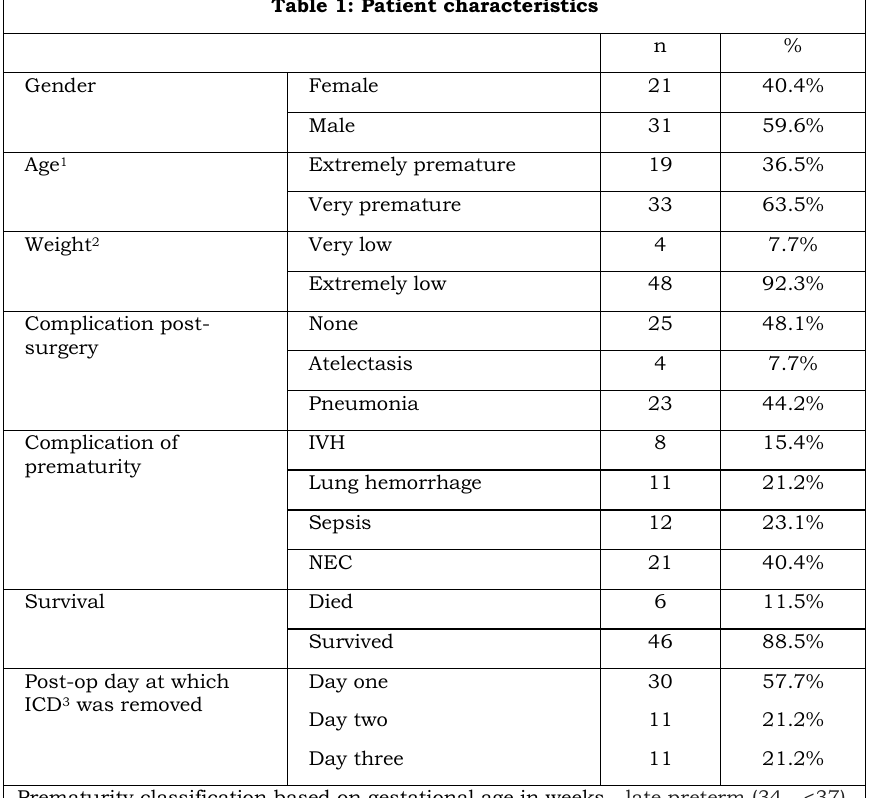
Table 1: Patient characteristics